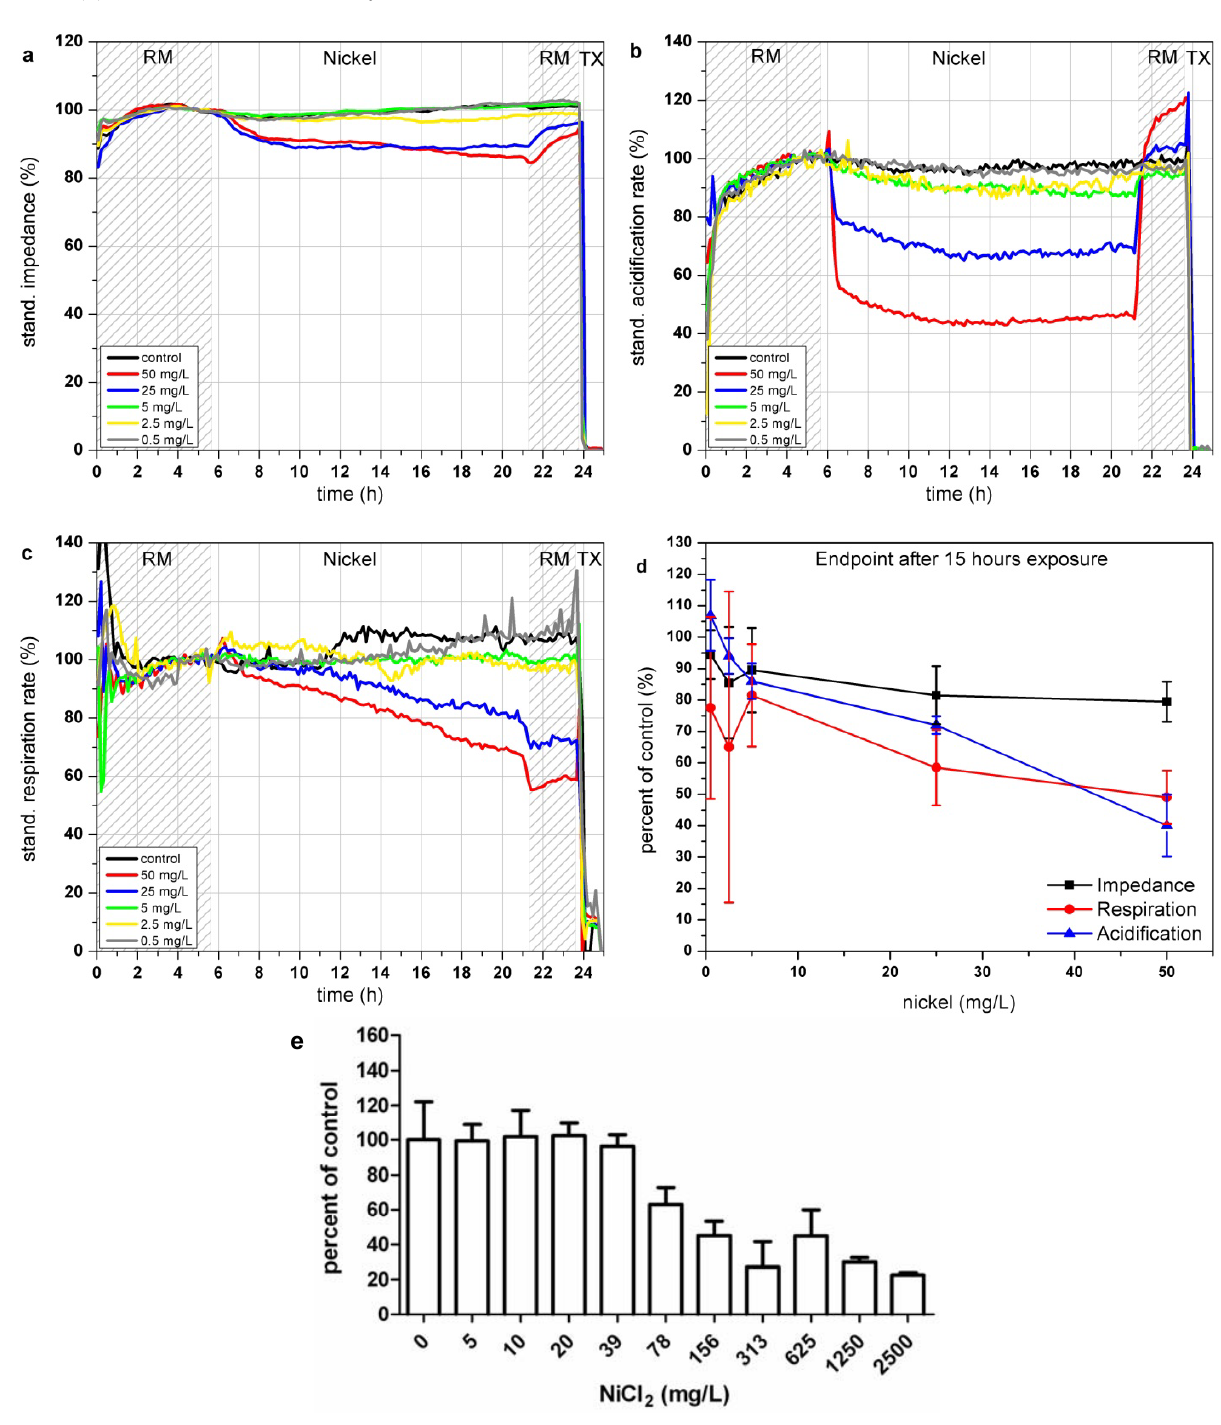
Figure 4. Time course of the impedance ( a ), acidification ( b ) and respiration ( c ) of L6 rat skeletal muscle cells during 24 h incubation with NiCl in the Bionas 2500 Analyzing 2 System. Vehicle control (black), 50 mg/L (red), 25 mg/L (blue), 5 mg/L (green), 2.5 mg/L (yellow) and 0.5 mg/L (grey). Phases with running medium (RM) represent culture medium treatment without added substances. ( d ) Percent of control of impedance, respiration and acidification endpoint values measured after 15 h of nickel chloride exposure (n = 3). ( e ) Results of BrdU assay of L6 cells incubated with nickel chloride for 24